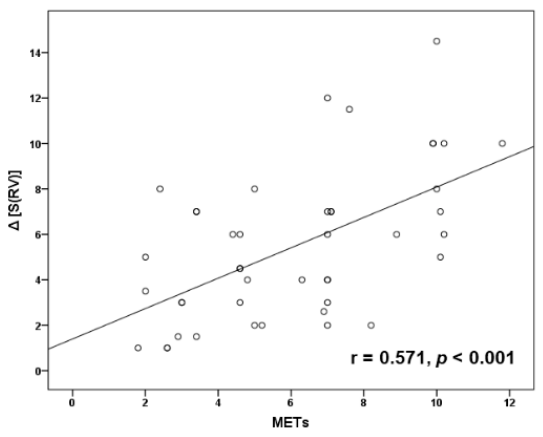
Figure 4. Scatter plot correlation of maximal achieved workload in METs with right ventricular (RV) inotropic reserve defined by the difference between post-exercise and prior to exercise S wave of RV, i.e., Δ (S(RV)).